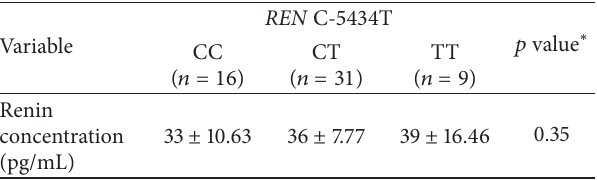
Table 2: Comparison of genetic variant REN C-5434T and serum renin